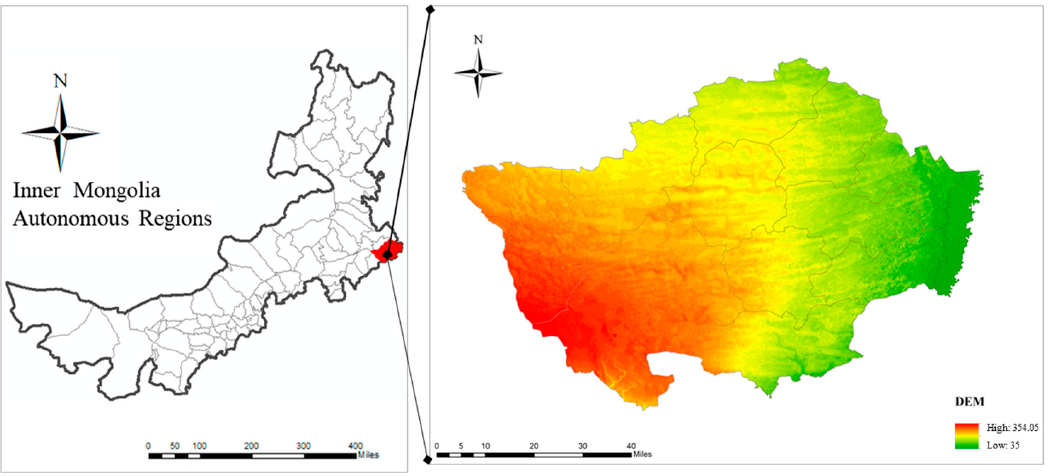
Figure 1. Overview of the study area.